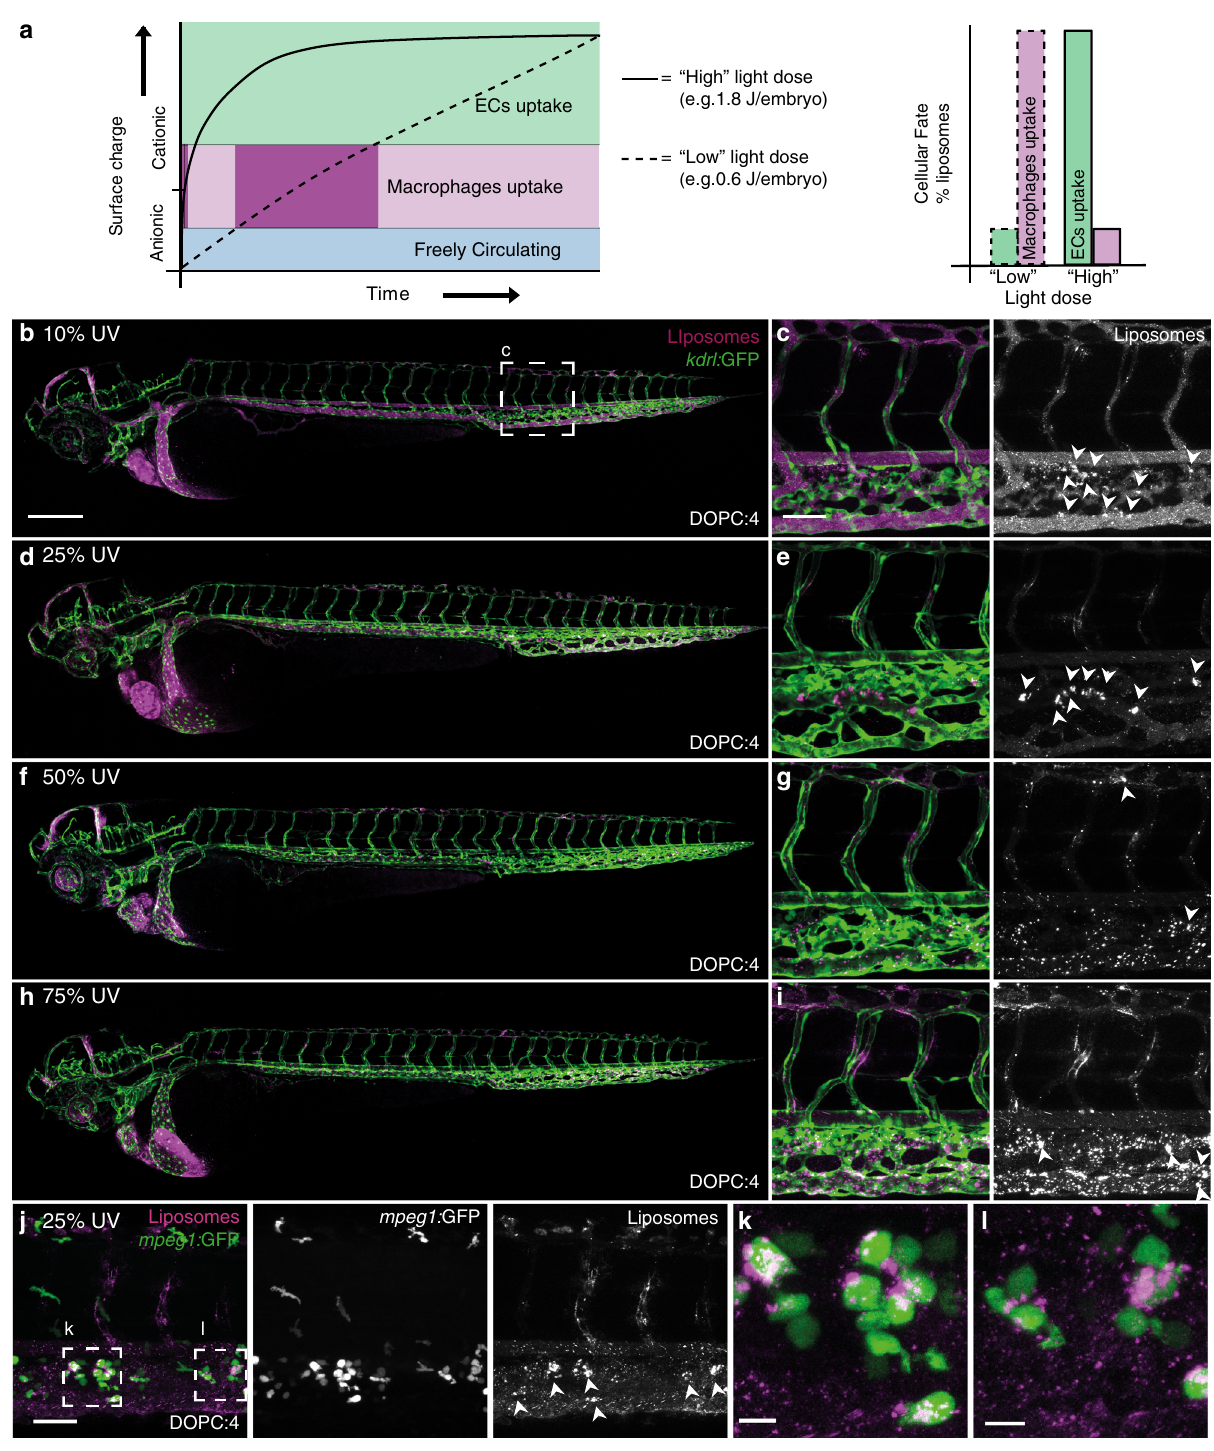
Fig. 6 Effect of light dose on the in vivo fate of DOPC:4 liposomes. a Reducing the UV light dose applied to the embryo increases the time taken for DOPC: 4 liposomes to transition to DOPC: 3 liposomes. This, in turn, increases the resident time spent by DOPC: 4 → 3 liposomes at an intermediate cationic surface charge density leading to irreversible clearance of liposomes by blood resident macrophages. b – i Whole embryo and tissue level views of DOPC: 4 liposome biodistribution in kdrl:GFP embryos following embryo irradiation with variable light doses (15 min, 370 ± 7 nm, ~90 mWcm − 2 , UV duty cycle stated for each image). Apparent liposome uptake in blood resident macrophages highlighted with white arrowheads. j – l Tissue level and zoomed views of DOPC: 4 → 3 liposome biodistribution in mpeg1:GFP embryos following embryo irradiation at 25% UV duty cycle (15 min, 370 ± 7 nm, 0.6 J per embryo). Liposomes contained 1 mol% fl uorescent lipid probe, DOPE-LR, for visualisation. Scale bars: 200 μ m (whole embryo); 50 μ m (tissue level), 10 μ m